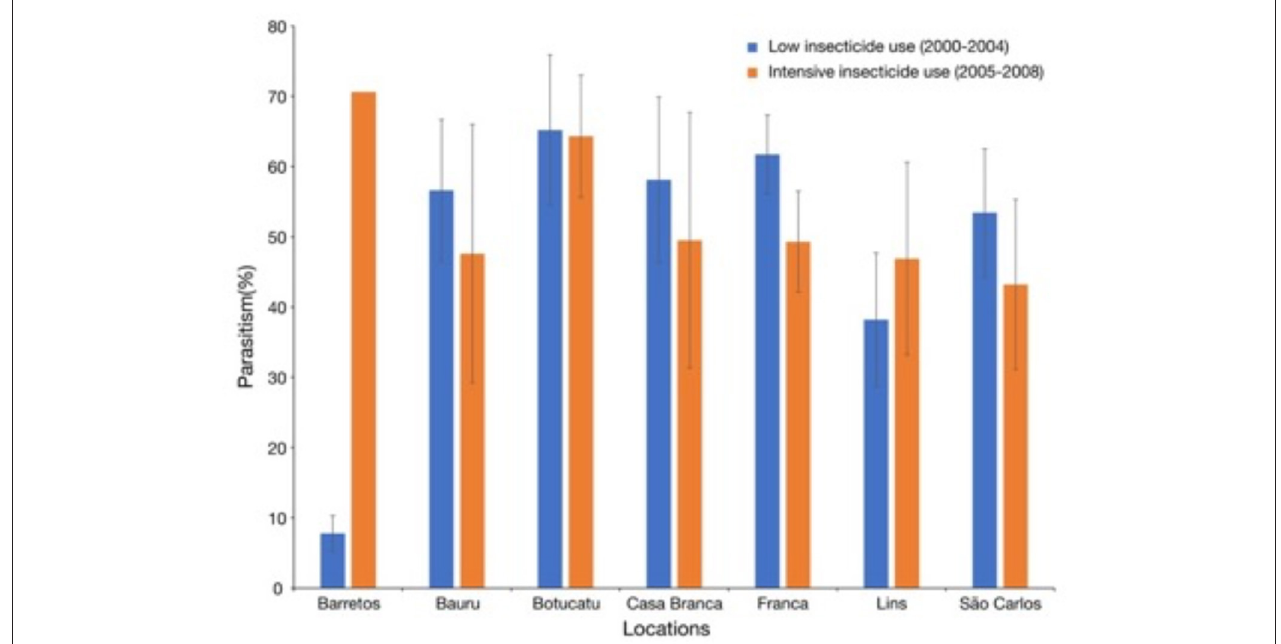
FIGURE 3 | Parasitism rate of Ageniaspis citricola on Phyllocnistis citrella at different locations with different pesticide application levels (Paiva and Yamamoto, 2015).